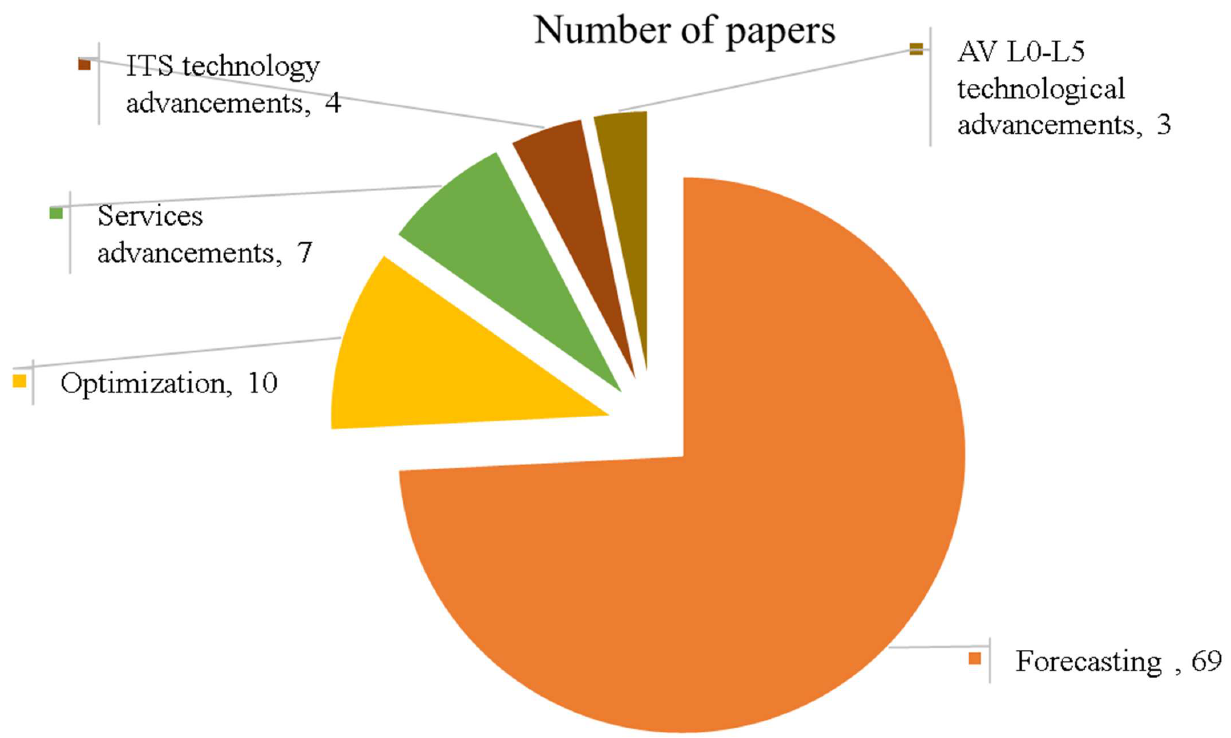
Figure 11. Number of papers in various applied research